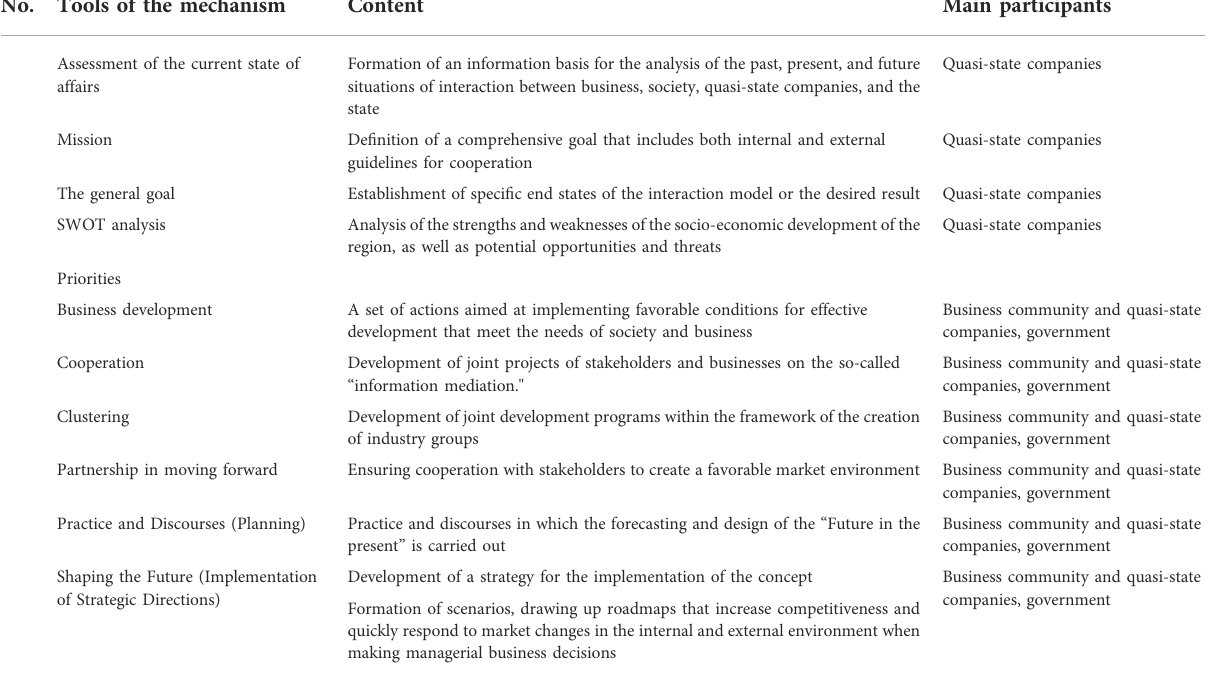
TABLE 1 Elements of the corporate foresight mechanism for quasi-public